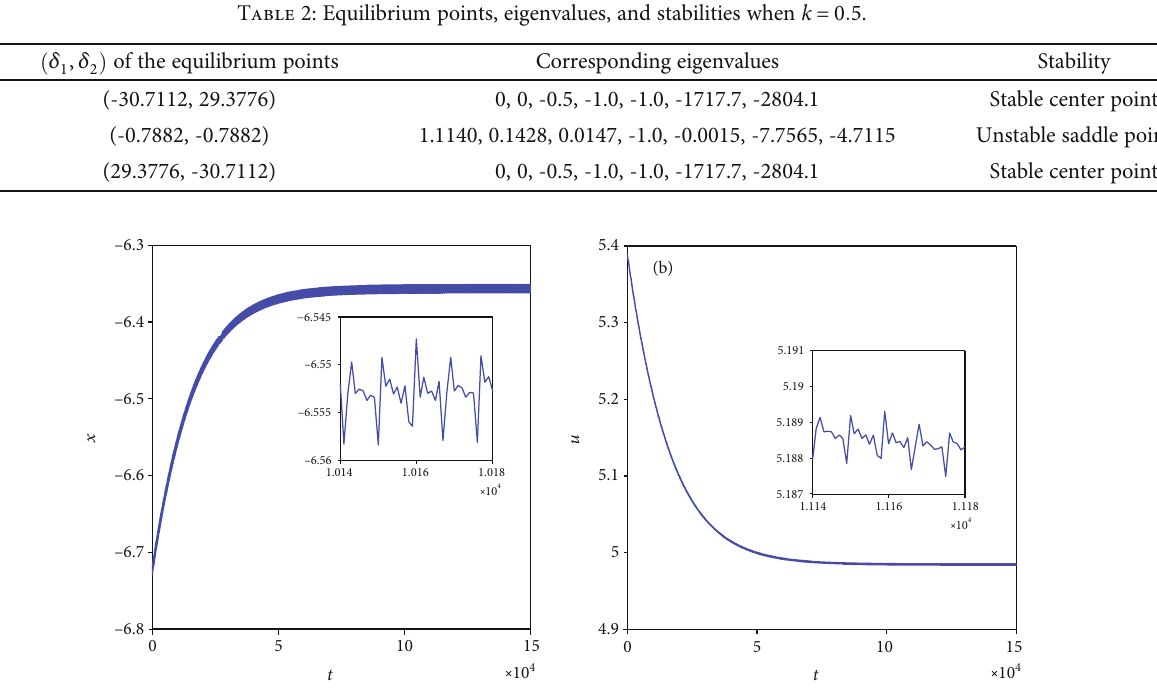
= 1 : 4 , and initial value ð − 2, 0, 0, 2, 0, 0, 0 Þ . ext